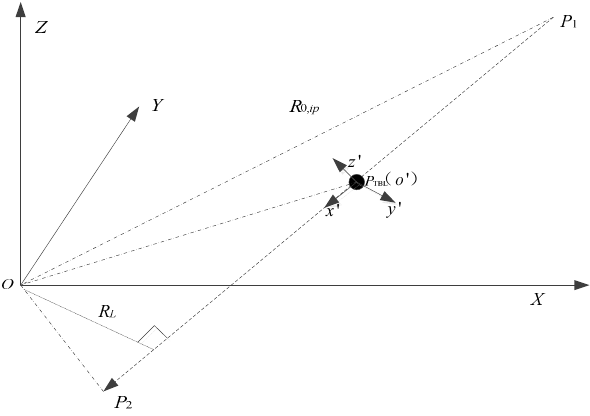
Figure 5. Rotation angle estimation schematic.